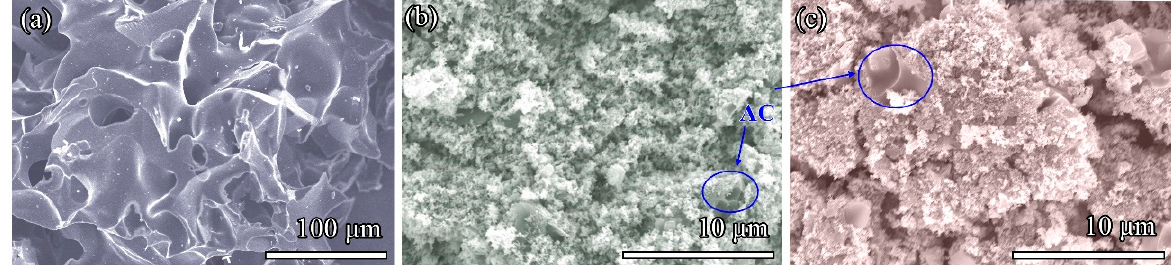
Figure 1. SEM images of the as-prepared samples: ( a ) AC, ( b ) Fe-AC, and ( c ) Fe/Ni-AC. Table 1. Elemental compositions on the surfaces based on EDX analysis. BET surface areas for AC, Fe-AC, and Fe/Ni-AC.